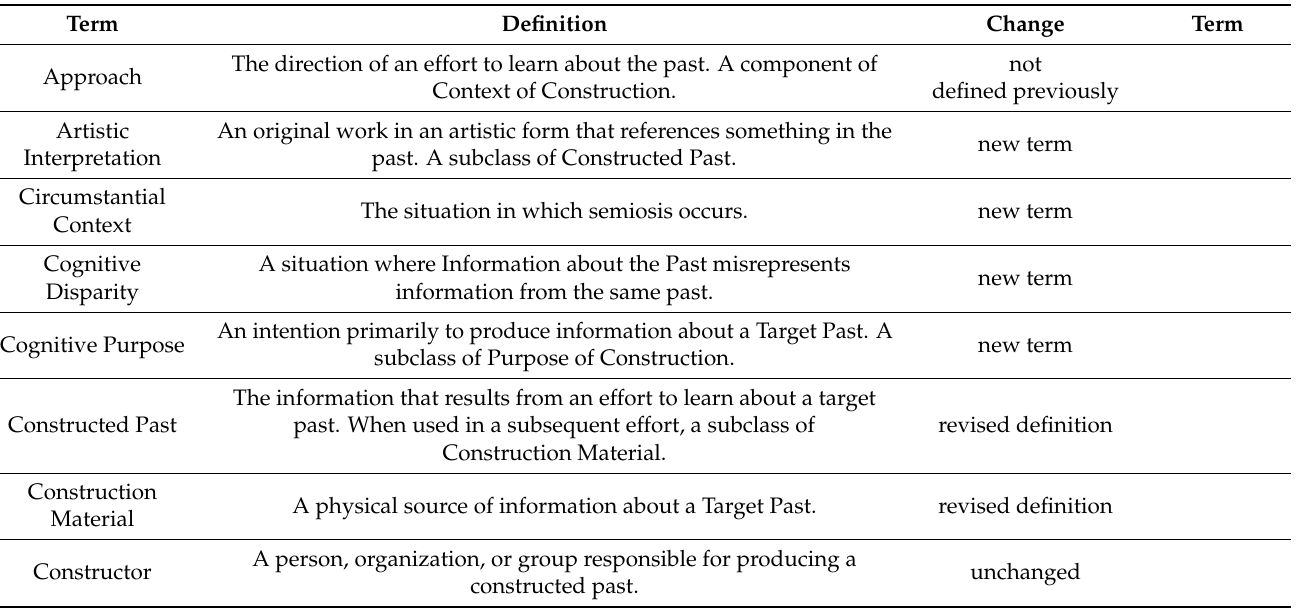
Table A1. Glossary of UML Classes in Constructed Past